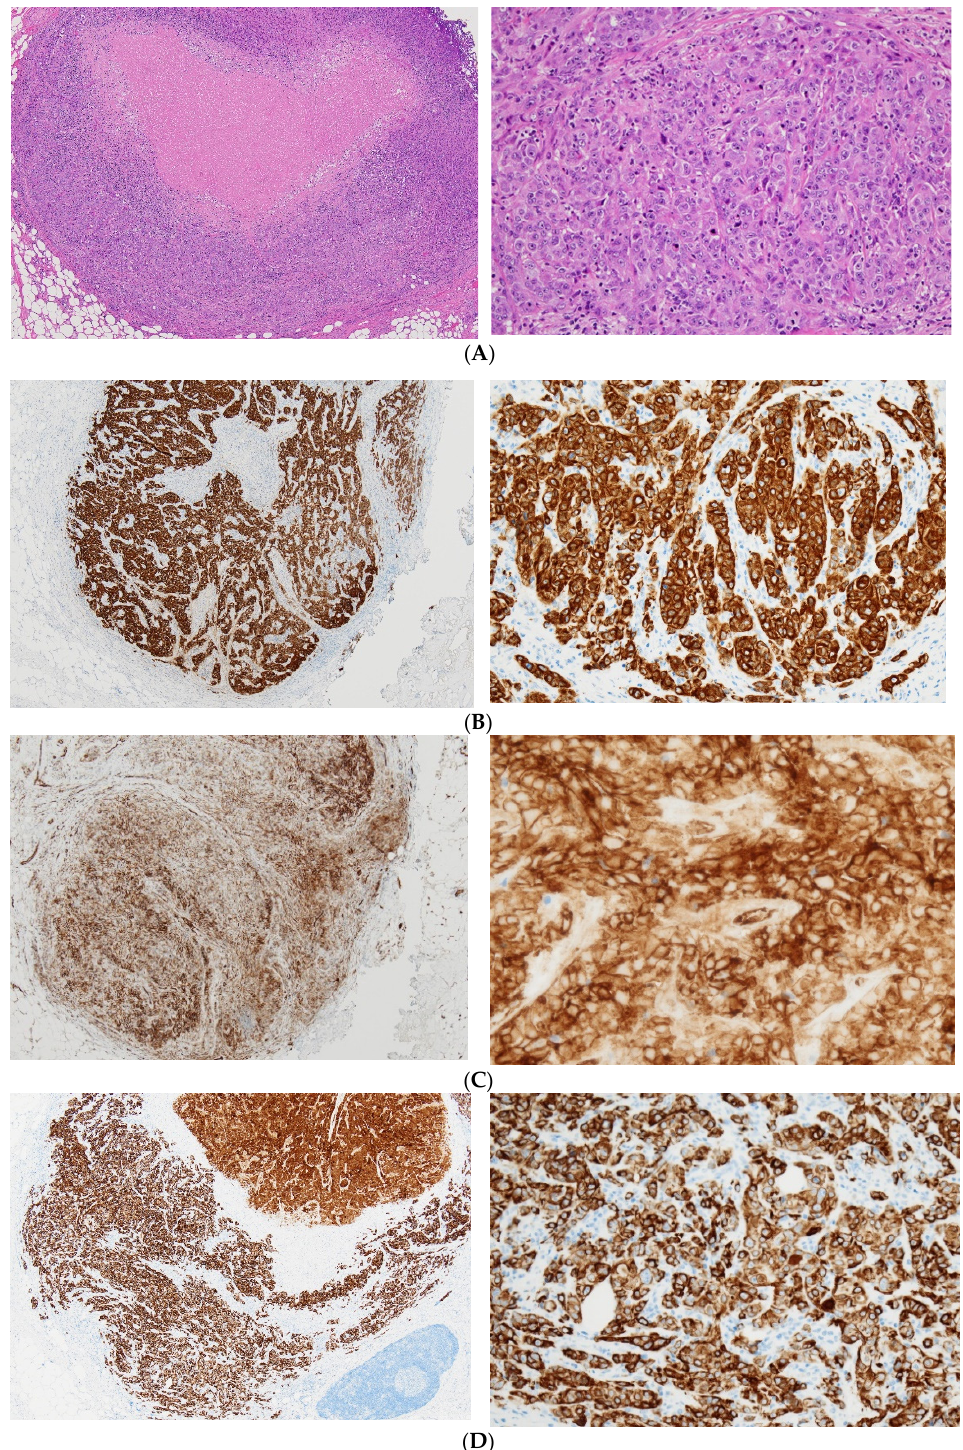
Figure 1. FDG-PET/CT performed before treatment. The figure shows FDG uptake in multiple lesions (liver, bone, and lymph node lesions). FDG-PET/CT: fluorine-18-2-deoxy-d-glucose posi- tron emission tomography and computed tomography.